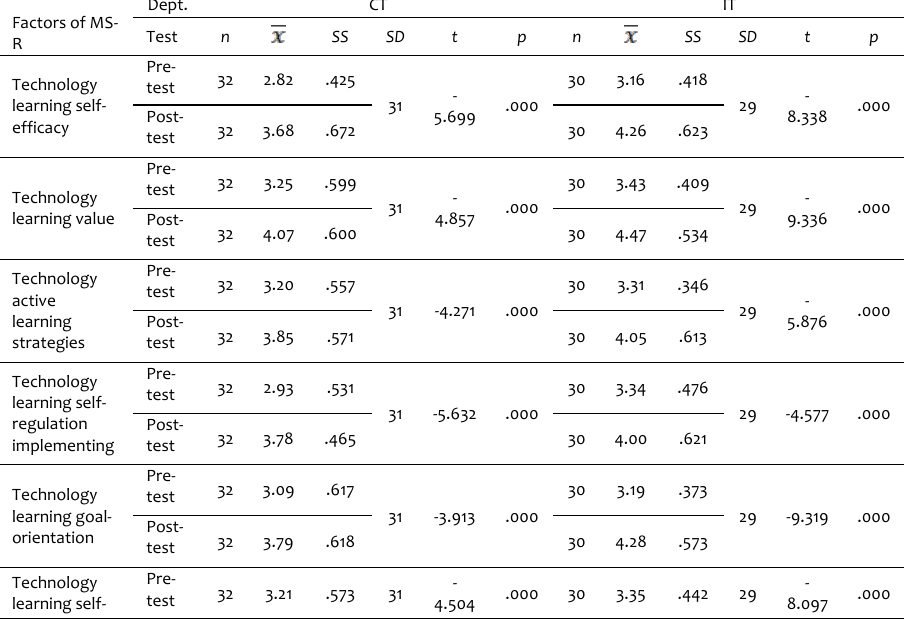
Table 6. Pre-test and post-test score comparison of Group Motivation and Self-regulation factors Factors of MS-